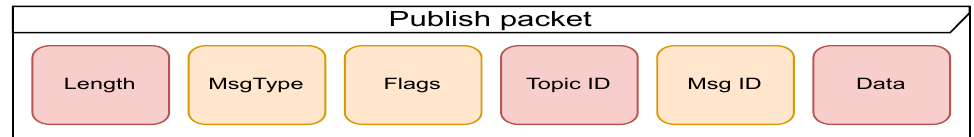
Figure 19. Publish packet format (congestion